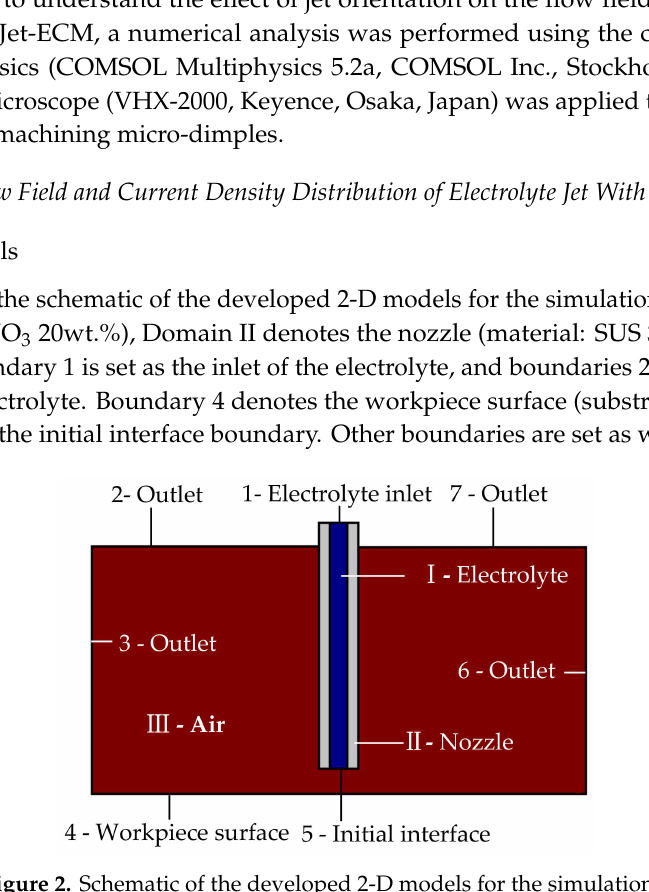
Figure 2. Schematic of the developed 2-D models for the